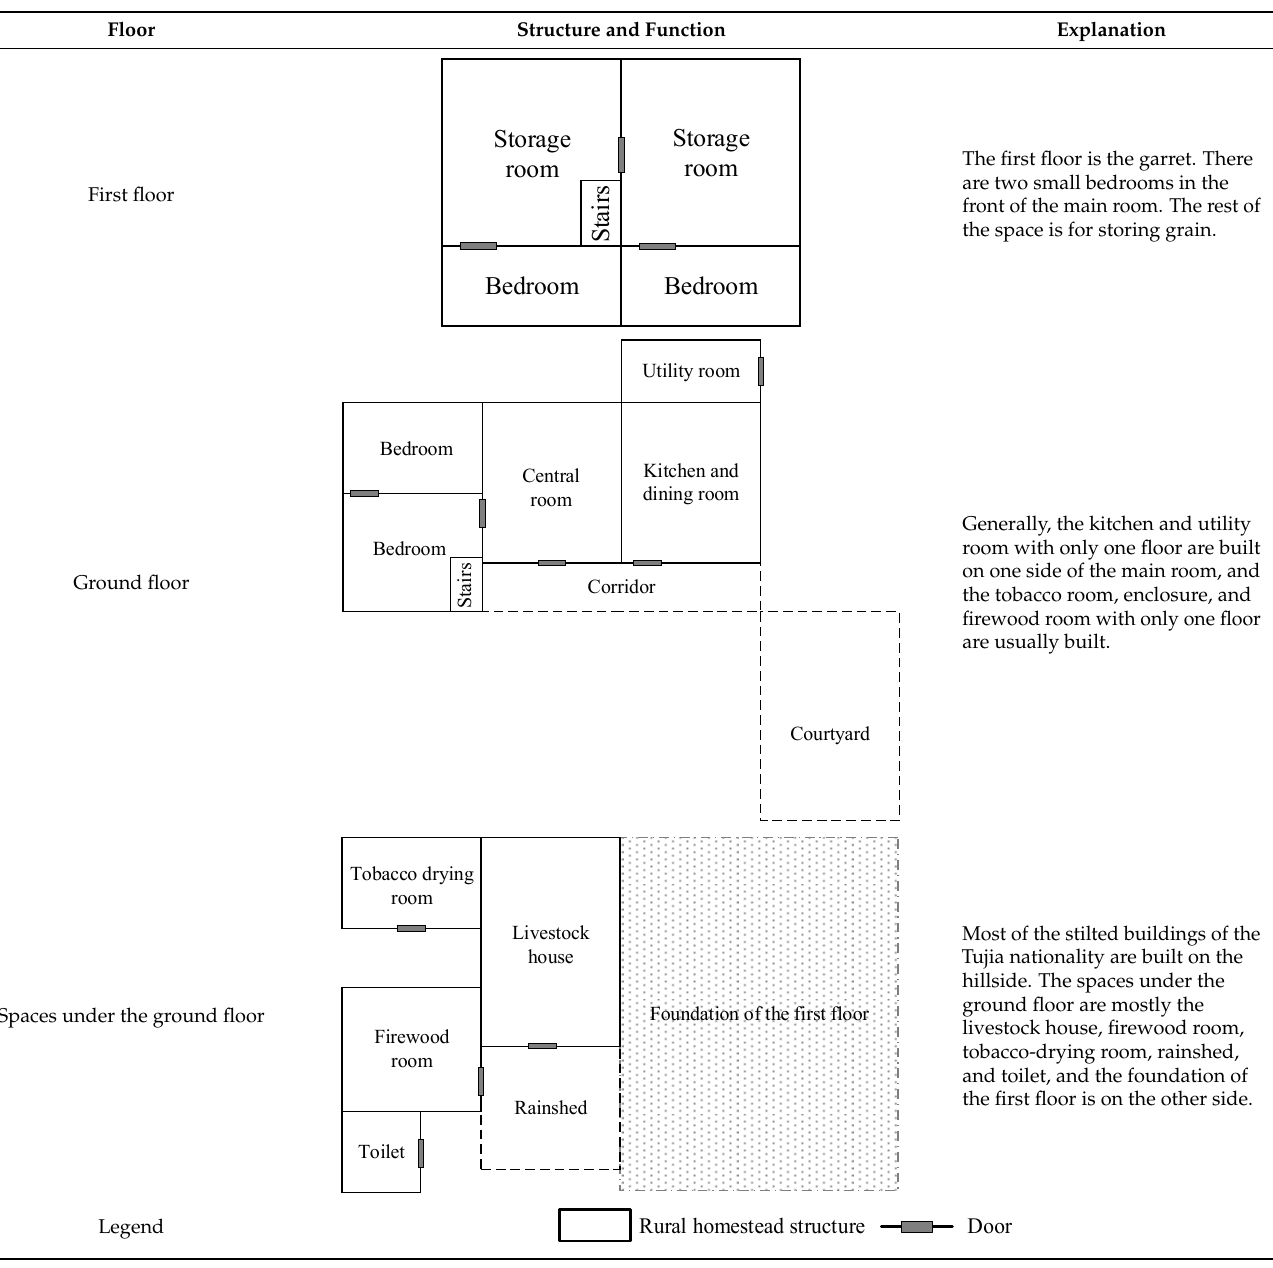
Table 3. The internal structure and function of the homestead before the operation of homestay in Xiniu village.